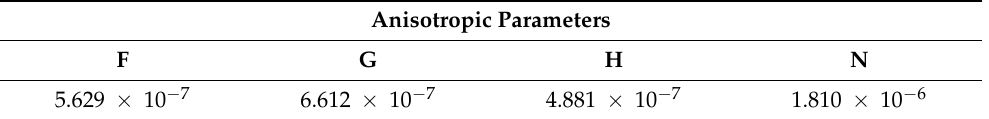
Figure 5. FE modeling to evaluate mesh size sensitivity at the stamping process contact interface. Table 6. The anisotropic parameters of the Hill’s 1948 yield criteria used in the simulation. Table 5. FE model details and computational time for each element size case.